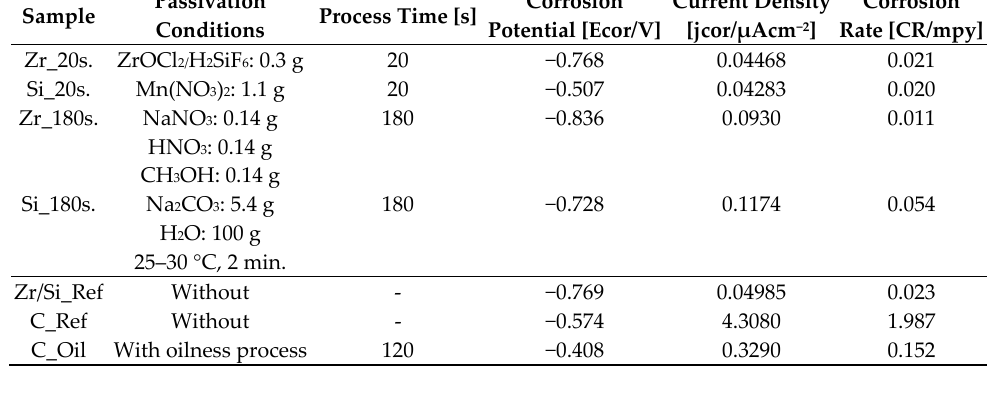
Table 11. The values of corrosion potential, current density, and corrosion rate estimated for samples chemically treated in passivation conditions.